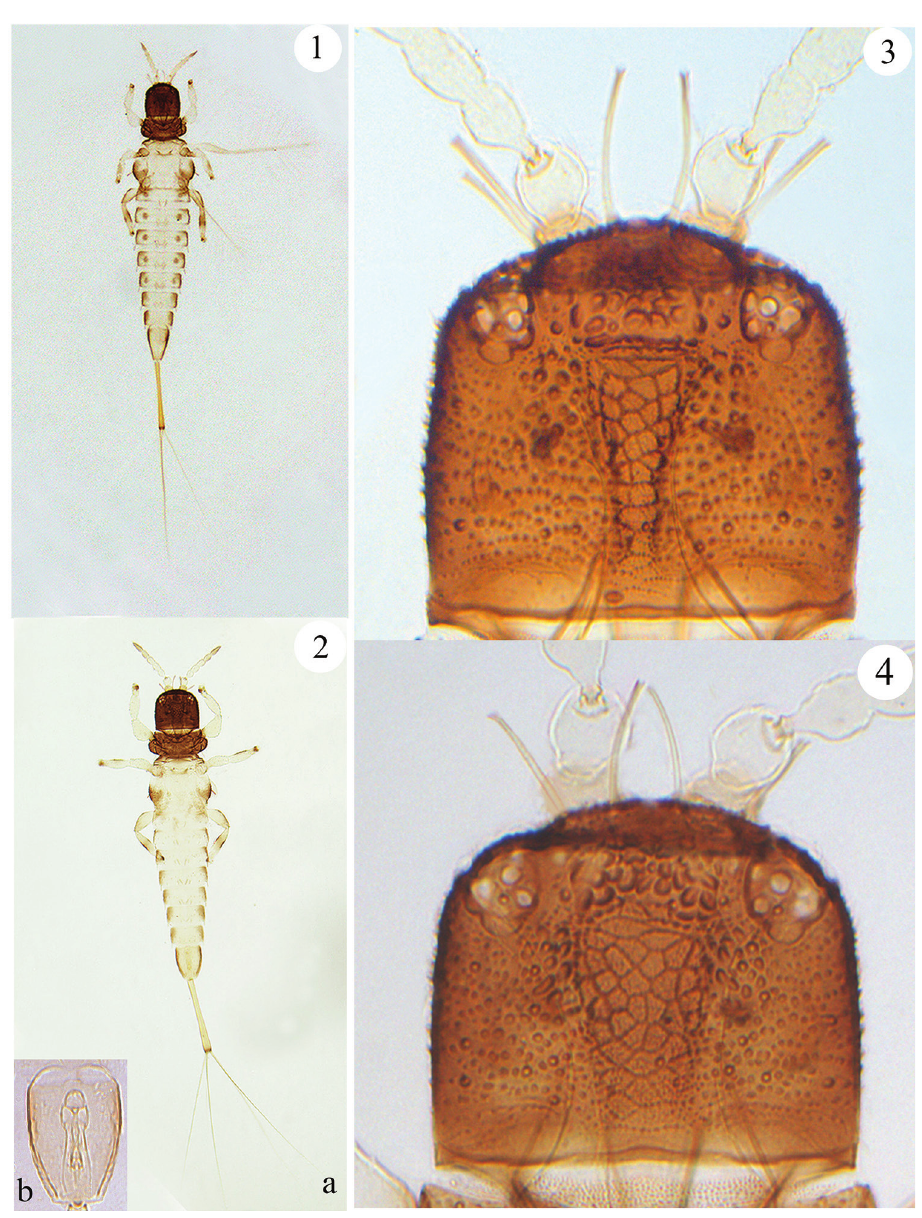
Figures 1–4. Baenothrips cuneatus sp. n. 1 female habitus 2a male habitus 2b male genitalia 3 head of female 4 head of male.